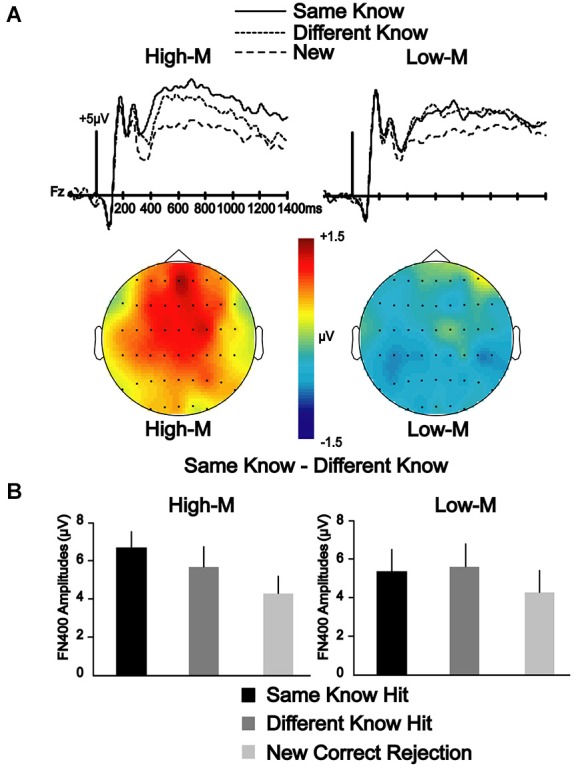
ERP correlates of color manipulation on FN400 for High-M and Low-M stimuli endorsed with know responses. (A) ERPs indicate the effect of color manipulation on amplitude of FN400 that occurred for know responses in Experiment 3 (High-M stimuli), but was not evident in Experiment 4 (Low-M). Topographic maps of the amplitude difference between Same-Know and Different-Know conditions shows a clear FN400 effect for High-M that is lacking for Low-M. (B) Mean amplitude of FN400 potentials corresponding to these effects for 350–500 ms for the frontal electrode cluster.